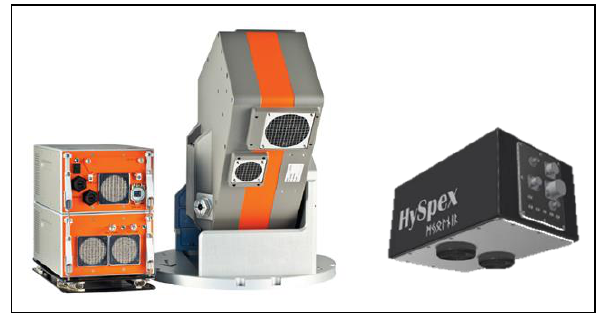
Figure 4. Hyperspectral camera AISA Fenix 1k for airplane (left) and Hyspex Mjolnir FR (right)